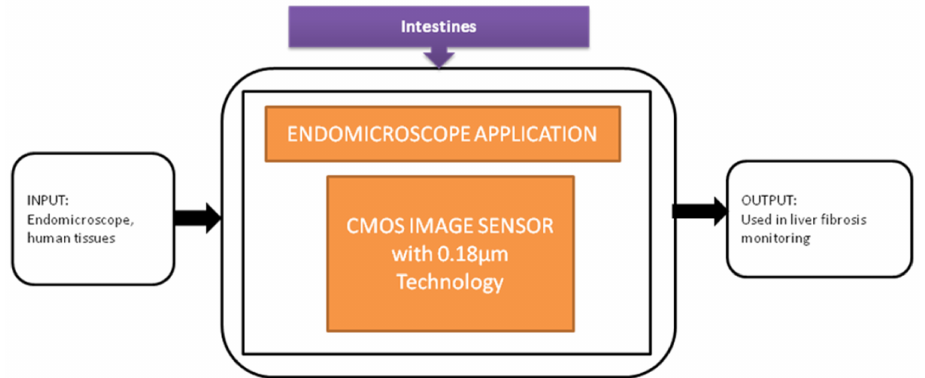
Figure 27. Endomicroscopic application with self-energy harvest